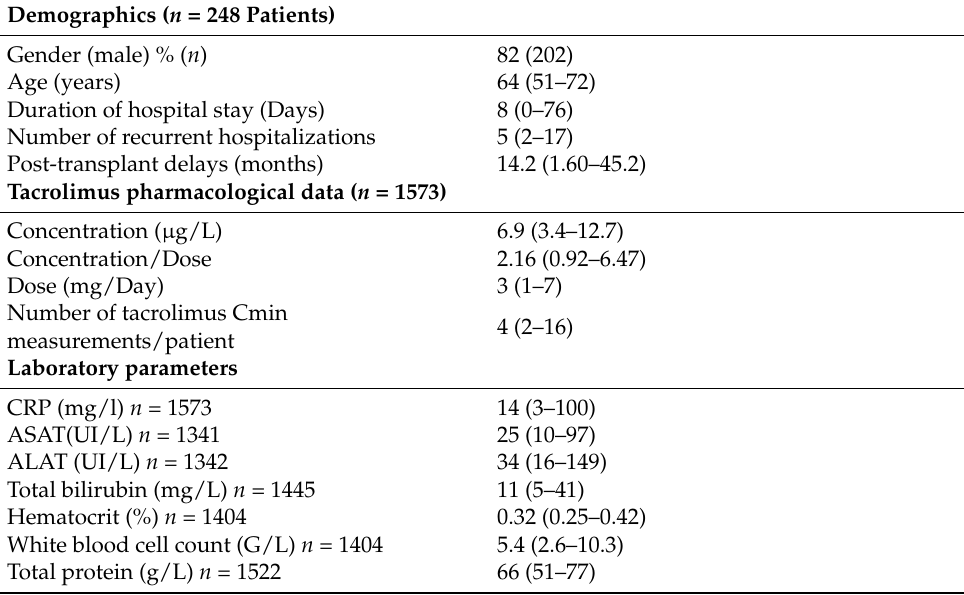
Table 1. Characteristics of patients and tacrolimus therapeutic drug